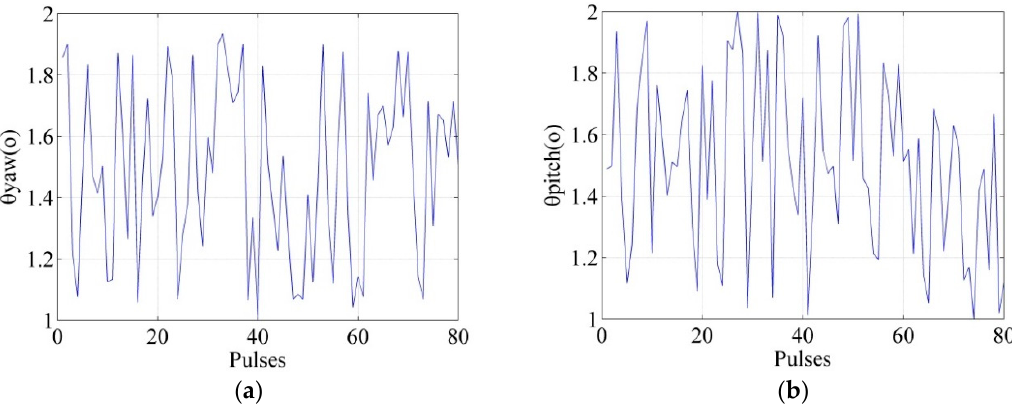
Figure 5. Random yaw angle and pitch angle. ( a ) The yaw angle; ( b ) The pitch angle.